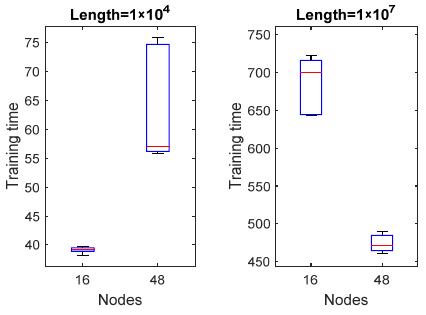
Figure 7. Training time distribution of dataset 1 in lengths of 1 × 10 4 , 1 × 10 7 and in nodes of 16, 48. In small datasets, less nodes take less time, and the time distribution is stable. Large datasets show the opposite result.